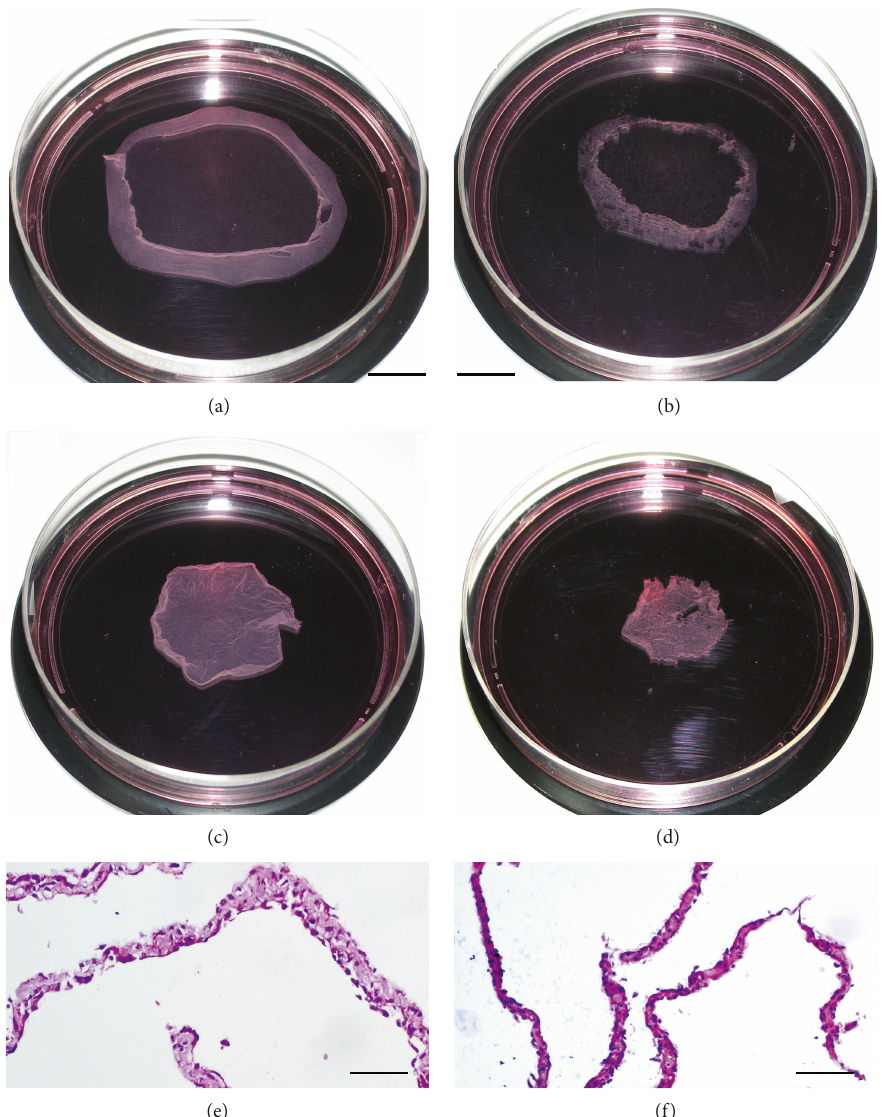
Figure 1: The gross and microscopic appearances of MSC sheets. MSC sheet induced with ascorbic acid before (a) and after (c) detachment from the culture dish. MSC sheet induced with standard osteogenic cocktail before (b) and after (d) detachment from the culture dish. Shrinkage in both groups of cell sheets was observed after complete detachment from the culture dish. The surface area of MSC sheet induced with ascorbic acid was larger than that of MSC sheet in the osteogenic group. In addition, as seen in histological examination, MSC sheet induced with ascorbic acid was thicker (e) than the MSC sheet in the osteogenic group (f). Scale bar =2cm for (a, b, c, d), scale bar =100 μ m for (e,